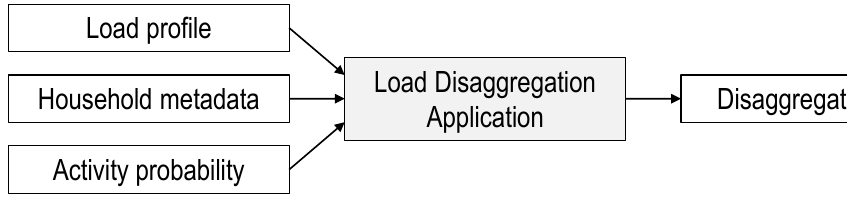
Figure 17. Block scheme of the load disaggregation